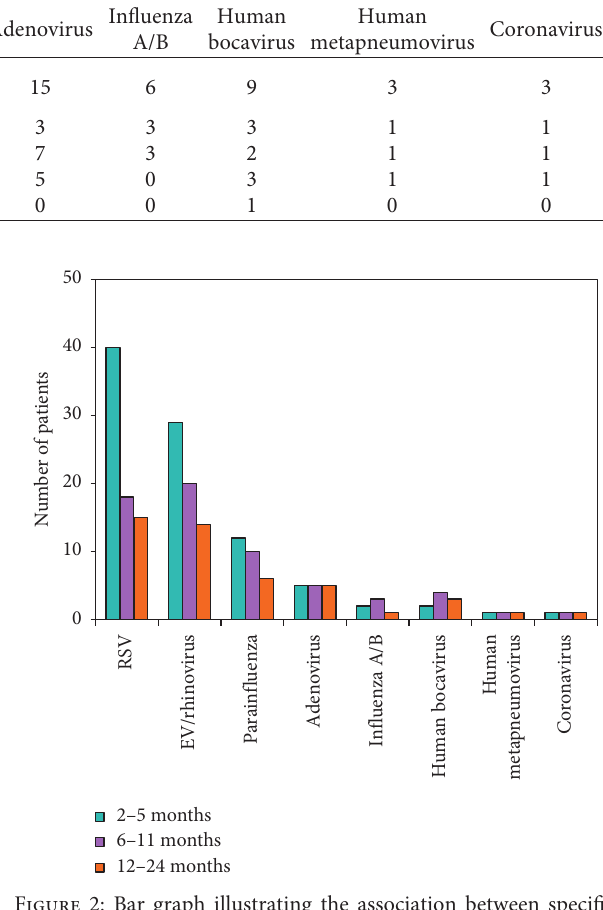
Figure 2: Bar graph illustrating the association between specific viral infections and clinical manifestations of acute respiratory infections. In the respiratory syncytial virus- (RSV-) infected group, the prevalence of pneumonia symptoms was significantly lower than that of bronchiolitis symptoms and significantly higher than that of bronchitis symptoms. In the enterovirus (EV)/rhi- novirus (Rhi) infected group, the prevalence of pneumonia symptoms was significantly higher than that of bronchitis symp- toms. Other viruses showed a similar prevalence of each mani- festation. ∗ p < 0 .